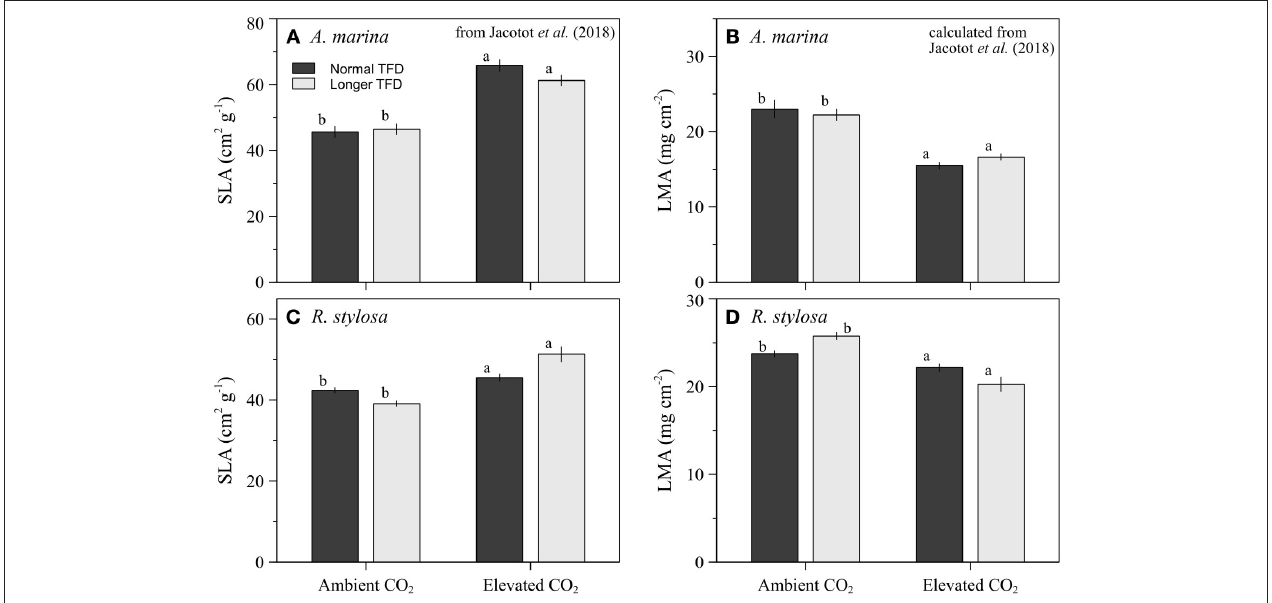
FIGURE 5 | Specific Leaf Area (A,C) and Leaf Mass Area (B,D) of A. marina and R. stylosa grown in ambient or elevated CO 2 , and under normal (dark-gray bars) and longer TFD (gray bars), for 12 months. Values are means ± SEM ( n = 30). Different letters indicate significant differences ( p < 0.05). Data are from Jacotot et al.